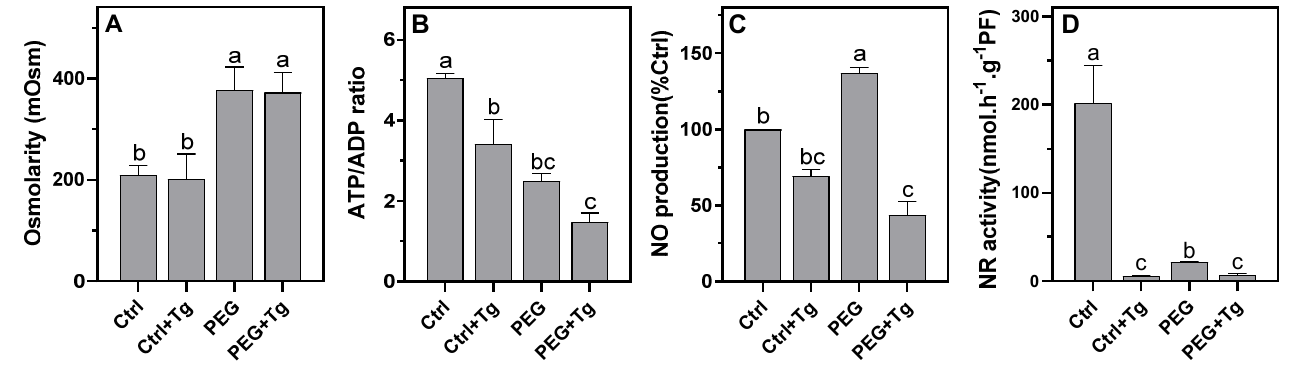
Figure 5. Effects of PEG 6000 osmotic stress and tungstate on Vicia faba nodule osmolarity ( A ), ATP/ADP ratio ( B ), NO production ( C ), and nitrate reductase activity ( D ). Data are means ± SD of three biological replicates. Letters above the bars represent significant differences according to one-way ANOVA at p < 0.05 (Tukey’s multi-comparison test). NO, nitric oxide; NR, nitrate reductase; PEG, polyethylene glycol 6000; Tg, tungstate.